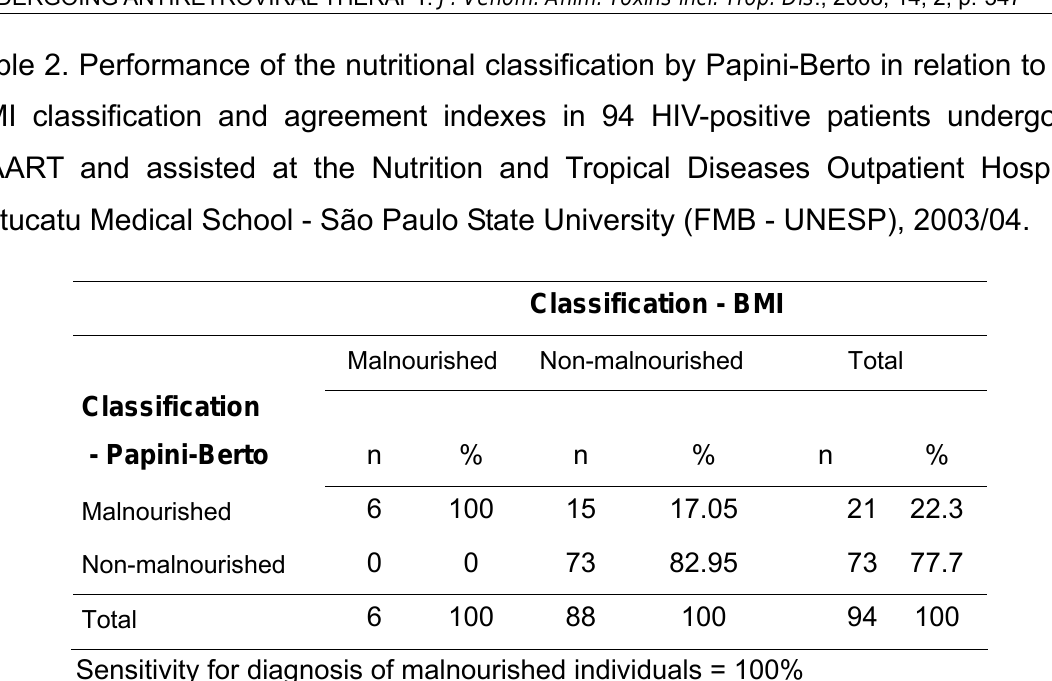
Sensitivity for diagnosis of malnourished individuals = 100% Specificity for diagnosis of malnourished individuals = 83% Correct classification % = 84% Table 3. Distribution of the 94 HIV-positive individuals undergoing HAART and attending the Nutrition and Tropical Diseases Outpatient Hospital, Botucatu Medical School – São Paulo State University (FMB - UNESP), according to waist-to-hips ratio (W/HR) and waist circumference (WC) in relation to BMI, 2003/04.